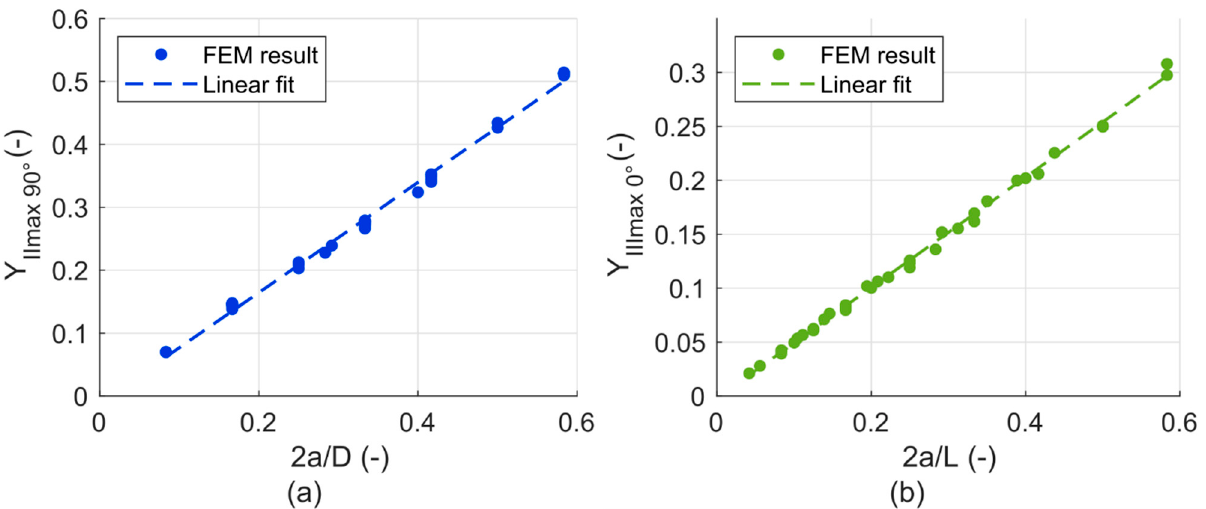
Figure 13. ( a ) Parametric functions fitting the values of Y IImax 90° ; ( b ) Parametric functions fitting the values of Y IIImax 0° .